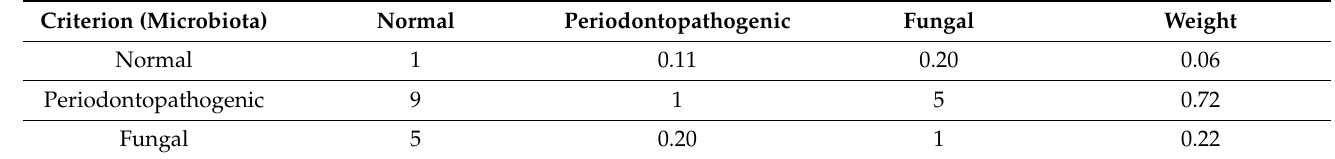
Table 13. The data on the paired comparison and the weights. Biological